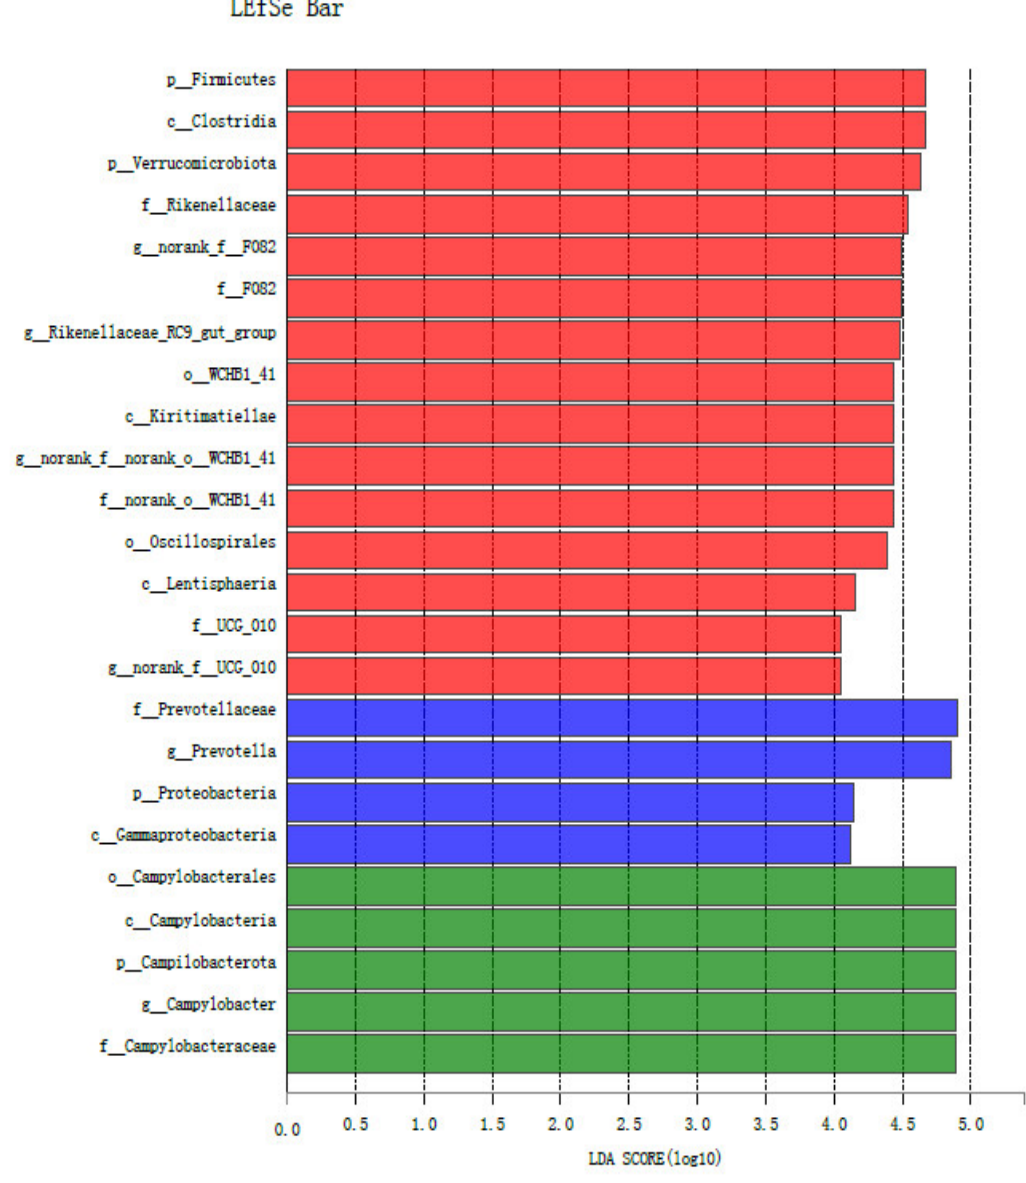
Figure 7. Biomarker bacterial genera in different treatment groups as revealed by LEfSe (LDA)-based analysis (LDA > 0.4).